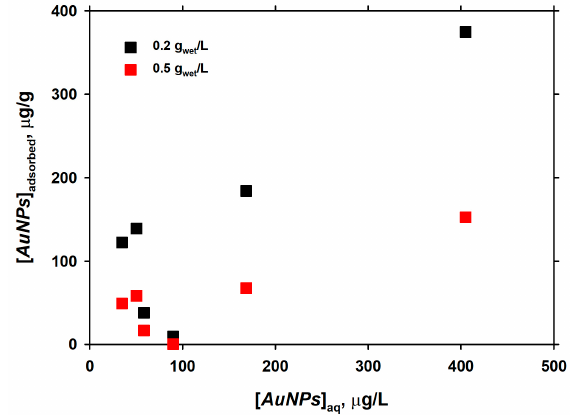
Figure 7. Adsorbed AuNPs as a function of aqueous AuNPs concentration in the presence of 0.2 and 0.5 g wet /L of EOMI diatoms, at pH of 6. The error bars are within the symbol size unless shown.